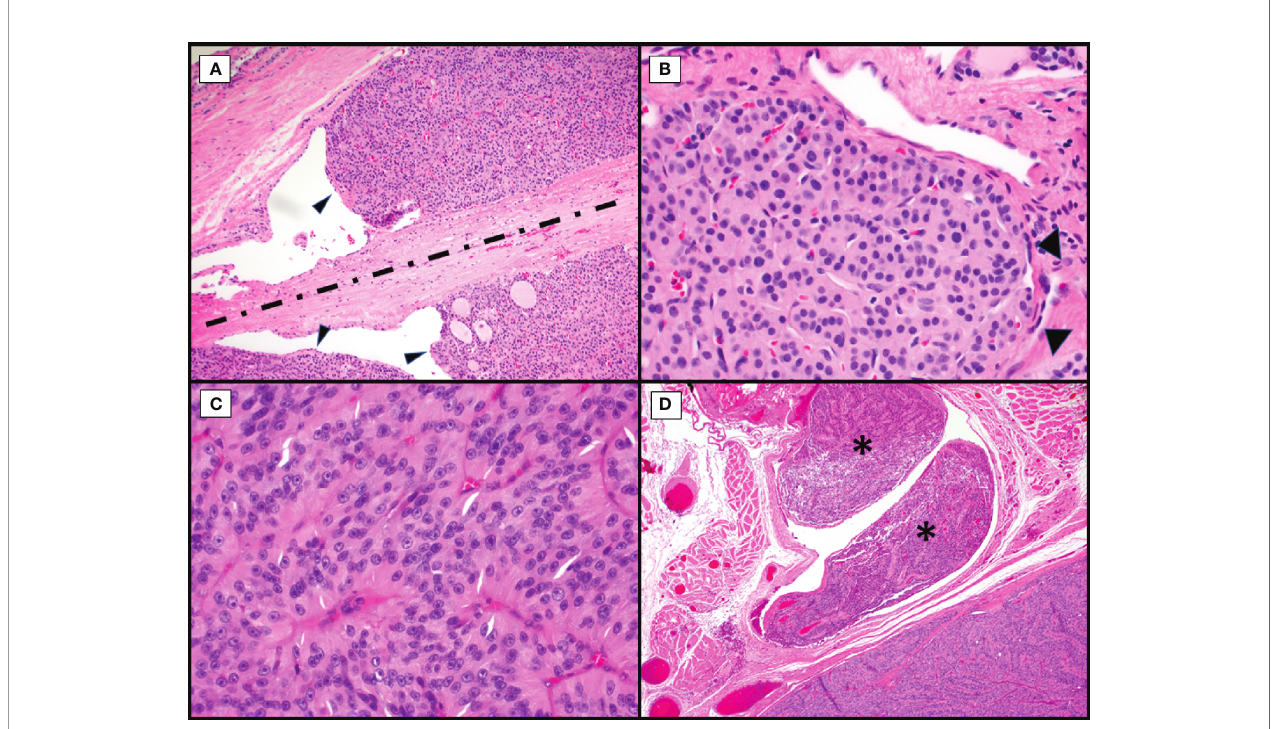
FIGURE 1 | Morphological Controversies. Hematoxylin and eosin stains of Hürthle cell carcinoma. Endothelial wrapping or bulging of tumor into endothelial lined spaces raises the question of lymphatic invasion. Tumor bulging ( A , arrowheads, 100X) is controversial with some requiring presence of intravascular thrombi. The band of fi brosis ( A , discontinuous line) raises the question of biopsy site versus capsule with invasion with some discussion of hemosiderin deposition (not seen here) to indicate needle track. Tumor nodule with surrounding endothelial cells ( B , arrowheads, 400X) in a space adjacent to the main tumor mass raises the possibility of capsular invasion versus vascular invasion versus focus of adjacent tumor in an unencapsulated lesion. Trabecular growth of true Hürthle cells ( C , 400X) with round nuclei, pale nucleoplasm and prominent, centrally located nucleoli in Hürthle cell carcinoma. In the same tumor, with trabecular growth ( D , 40X), shows an adjacent focus of overt vascular invasion in a large vessel located within the adjacent skeletal muscle